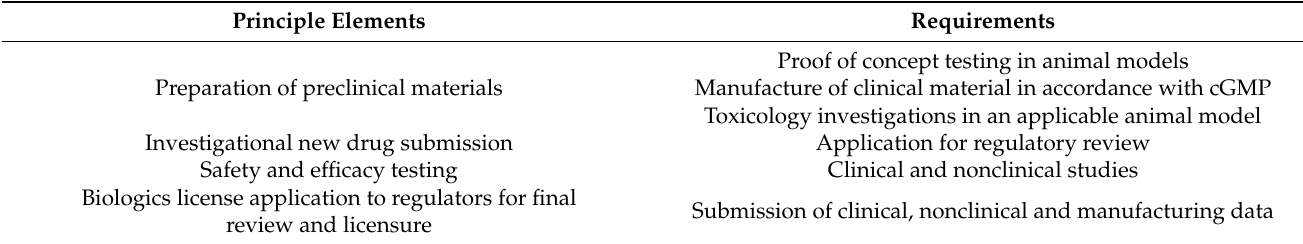
Table 2. The main elements of the regulatory approval process and their